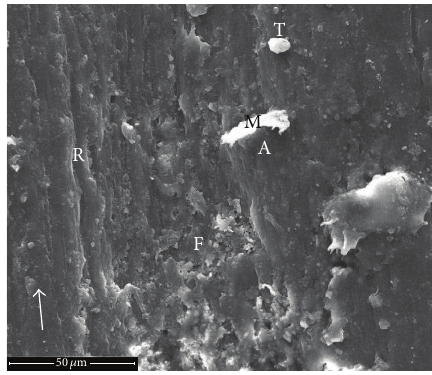
Figure 4: Scanning electron micrograph of TCE + PTFE composite abraded with sand particle size of 212 𝜇 m, to a distance of 2185 m and at load of 40 N.